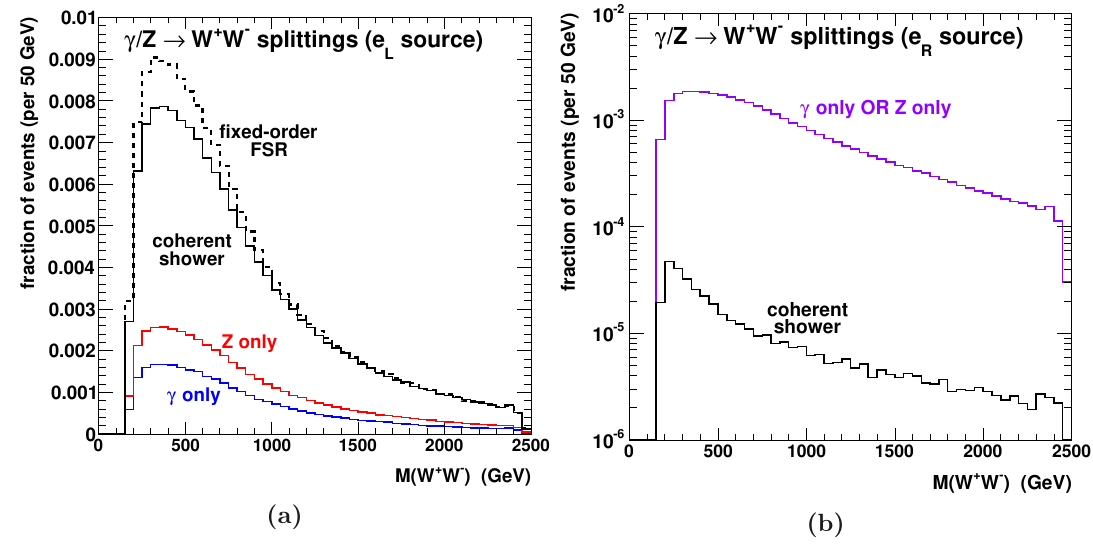
Figure 7. Invariant mass distributions for W + W − produced in the EW splitting of a 2.5 TeV γ/Z neutral boson, initiated from (a) e L current with full coherent EW FSR (solid curve), fixed- order FSR (dashed curve), and the hypothetical incoherent γ or Z splittings (lower curves); (b) e R current with full coherent EW FSR (solid curve) and the hypothetical incoherent γ or Z splittings (upper